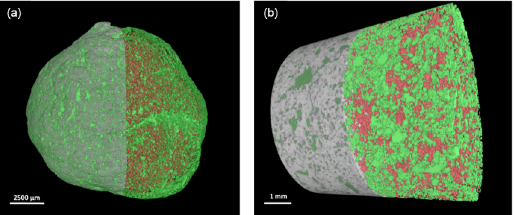
Figure 12. 3D models (open pores in green and closed pores in red): (a) 0.4X; (b) 4X.